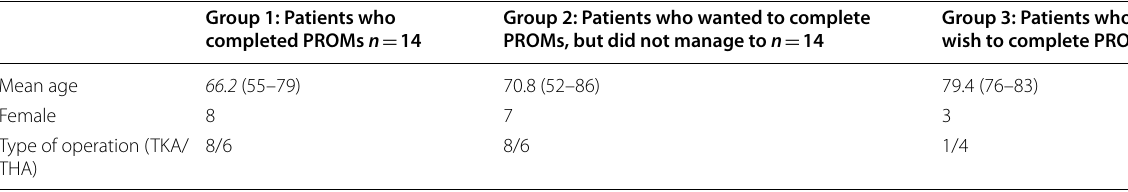
Table 3 Demographics of participants in the three groups Group 1: Patients who completed PROMs